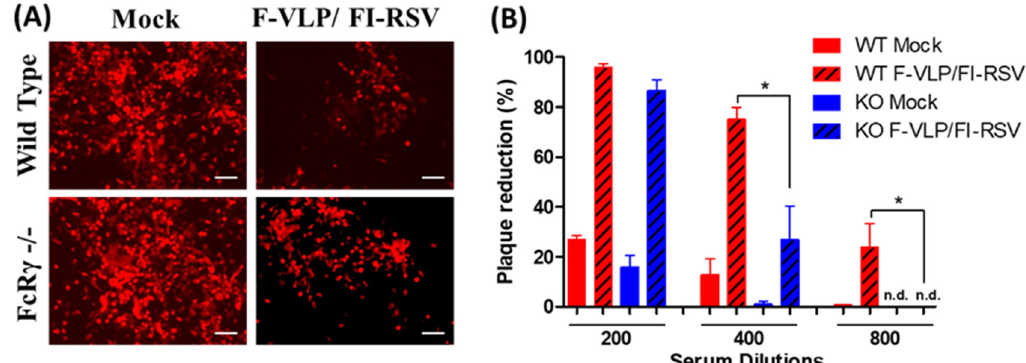
Figure 2. RSV-neutralizing titers of serum samples collected at 2 weeks after the boost. Diluted sera incubated with RSV A2-K-line19F (500 PFU) were added to HEp-2 cell monolayers to determine the reduction (%) in fluorescence intensity. ( A ) Fluorescence images of RSV-neutralizing activity in mock control or F-VLP/FI-RSV-immunized sera of WT and FcR γ − / − mice. ( B ) Data are presented as mean fluorescence reduction percentages ± SEM ( n = 5 per group). * p < 0.05.